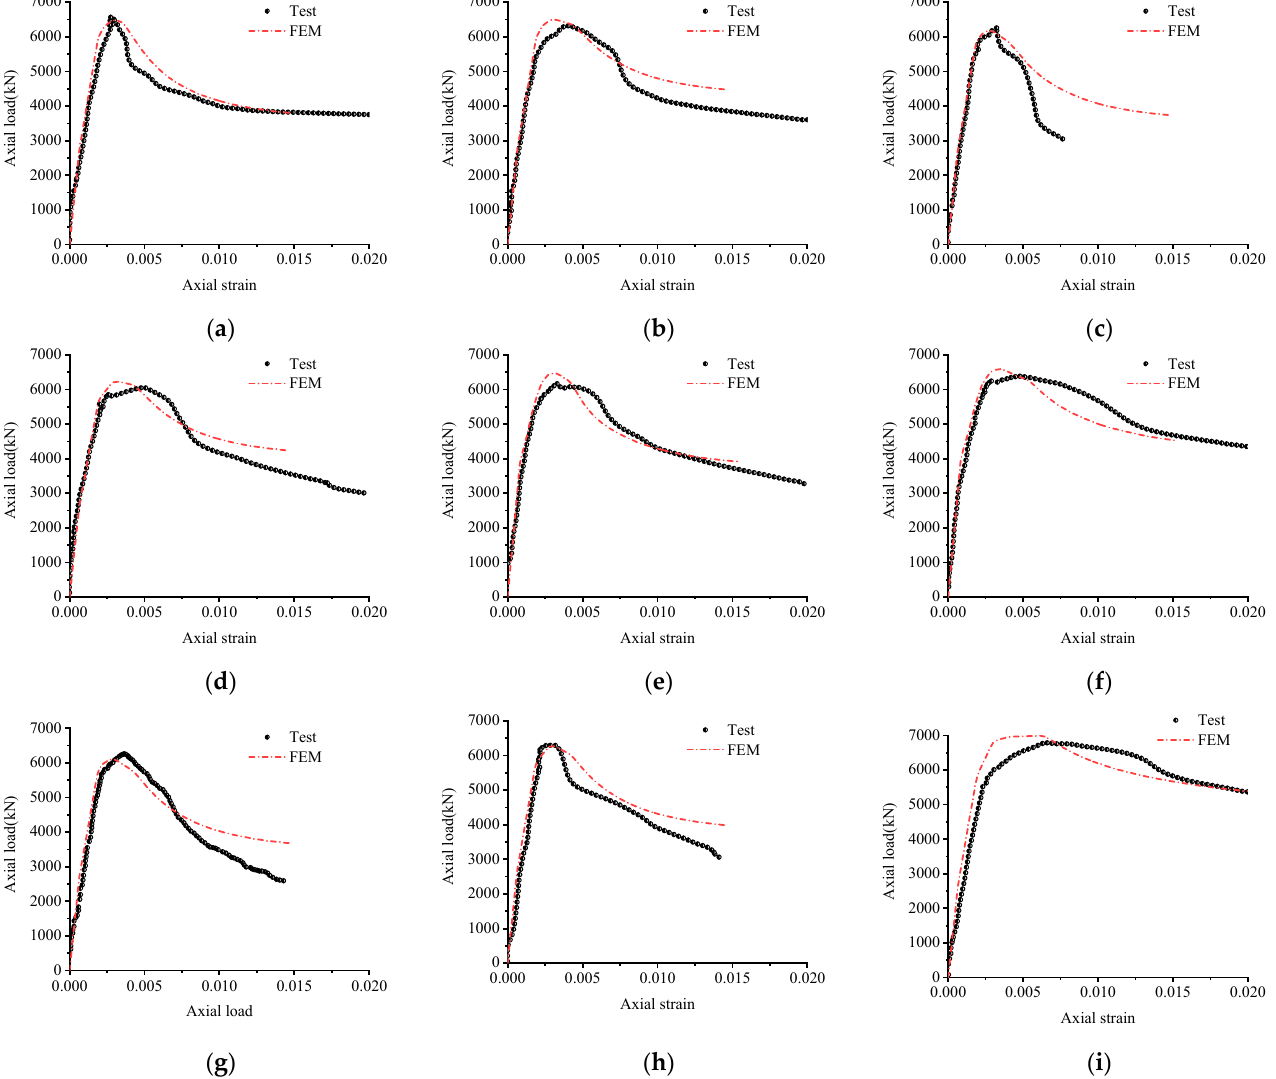
Figure 4. Comparison of test and simulation curves: ( a ) AC1; ( b ) AC2; ( c ) AC3; ( d ) AC4; ( e ) BC1; ( f ) BC2; ( g ) BC3; ( h ) BC4; ( i ) BC5.